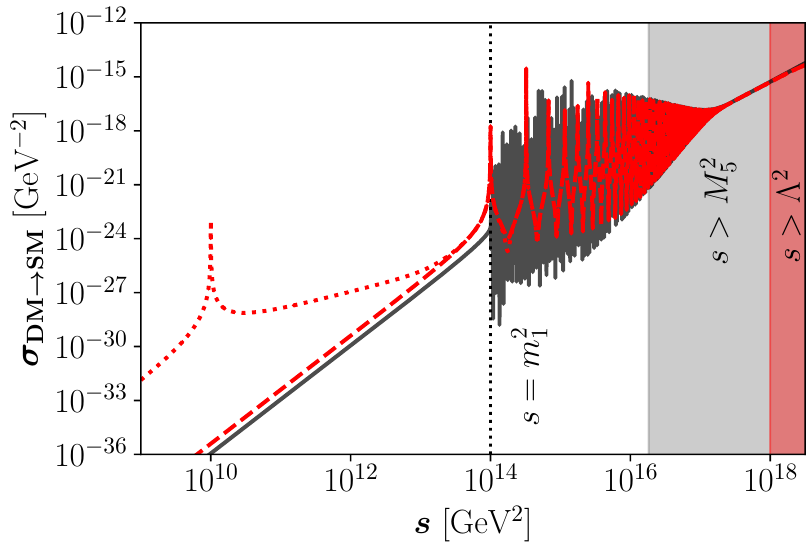
Figure 3 . The black solid line represents the DM annihilation cross-section in the CW/LD scenario for k = 10 7 GeV, Λ eff = 10 9 GeV (that corresponds to M 5 = 1 . 35721 × 10 8 GeV) and m DM = 1 MeV. The red-dashed (red-dotted) line represents the same process in the RS scenario, for m 1 = 10 7 GeV, Λ = 10 9 , m DM = 1 MeV and a radion mass m r = 10 7 GeV ( m r = 10 5 GeV). The gray- and red- shaded regions on the right of the picture represent the region of the parameter space that is beyond the EFT approach, as s is larger than the scale of the effective theory ( M 5 and Λ in the case of the CW/LD or the RS scenarios,